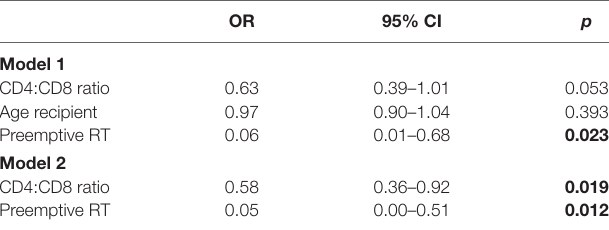
TaBle 4 | Multivariate regression analysis between rejection and immunological and clinical parameters.